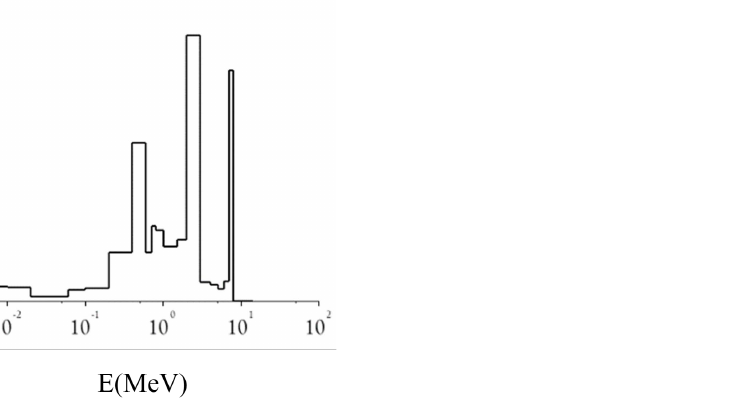
Figure 4. Neutron fluence rate distribution on the x axis ( A,B ) and y axis ( C,D ), normalized at 1 MW reactor power. Table 1 displays the calculated and measured thermal fluence rates in the cellular irradiation box. The standard deviation of the simulations with different seed random numbers was in the order of 0.5% and is included in the uncertainty. The agreement be-